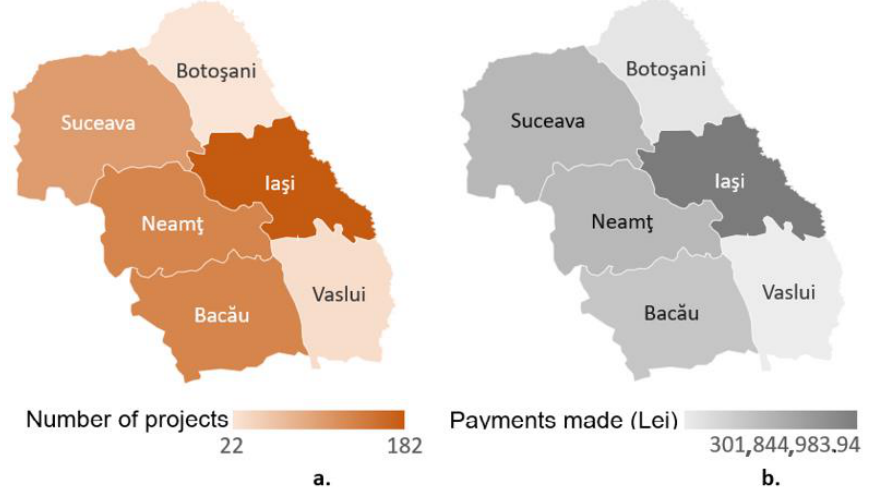
Figure 4. Number of contracted projects ( a ) and value of projects ( b ) for the NEDR (Romania, 2009–2015). Source: Data processed by the authors (https://beneficiar.fonduri-ue.ro:8080/proiecte/, accessed on 14 April 2022).